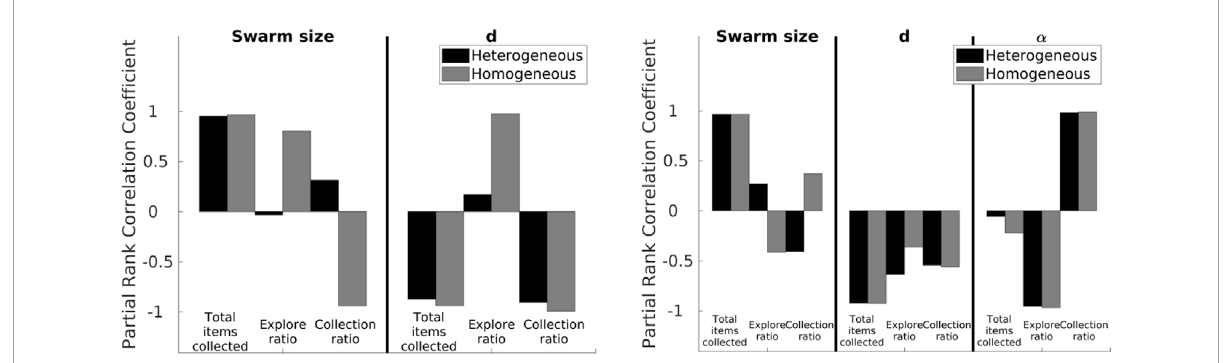
FIGURE 7 LHA for the NPS (left) and DPS (right) with homogeneous and heterogeneous error. Left: correlations change for each error type except for the total items collected for both parameters ( swarm size and d ) and the collection ratio for the d parameter. Right: results are similar between heterogeneous and homogeneous errors except for the correlation between the swarm size term, the explore ratio , and the collection ratio .